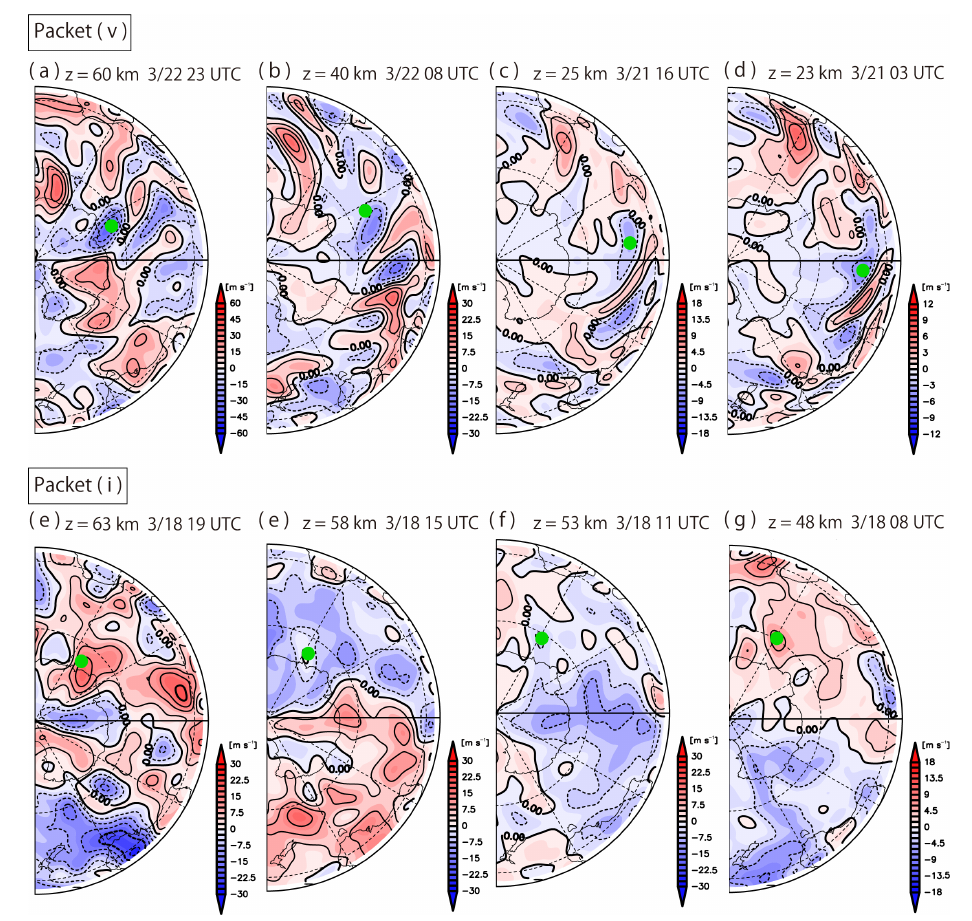
Figure 12. Snapshots of the zonal wind components of the large-scale inertia–gravity waves tracing the packet (v) (a) at the height of 60km at 23:00UTC, 22 March (contour interval 10ms − 1 ) , (b) at the height of 40km at 08:00UTC, 22 March (contour interval 5ms − 1 ) , (c) at the height of 25km at 16:00UTC, 21 March (contour interval 3ms − 1 ) , and (d) at the height of 23km at 03:00UTC, 21 March (contour interval 2ms − 1 ) . Snapshots for the packet (i) (e) at the height of 63km at 23:00UTC, 22 March, (f) at the height of 58km at 15:00UTC, 18 March, (g) at the height of 53km at 11:00UTC, 18 March (contour interval 5ms − 1 ) , and (d) at the height of 48km at 08:00UTC, 18 March (contour interval 3ms − 1 ) . The green circles are locations of traced wave packets by the method discussed in the text. The data are from the NICAM